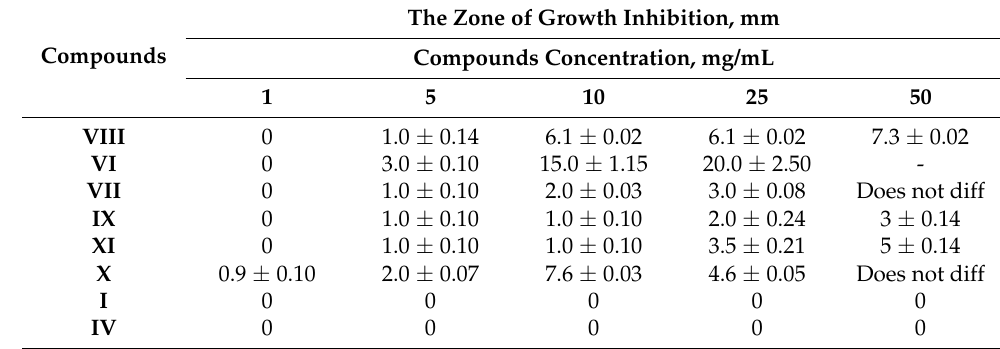
Table 3. Antibacterial properties compounds against Bacillus subtilis .